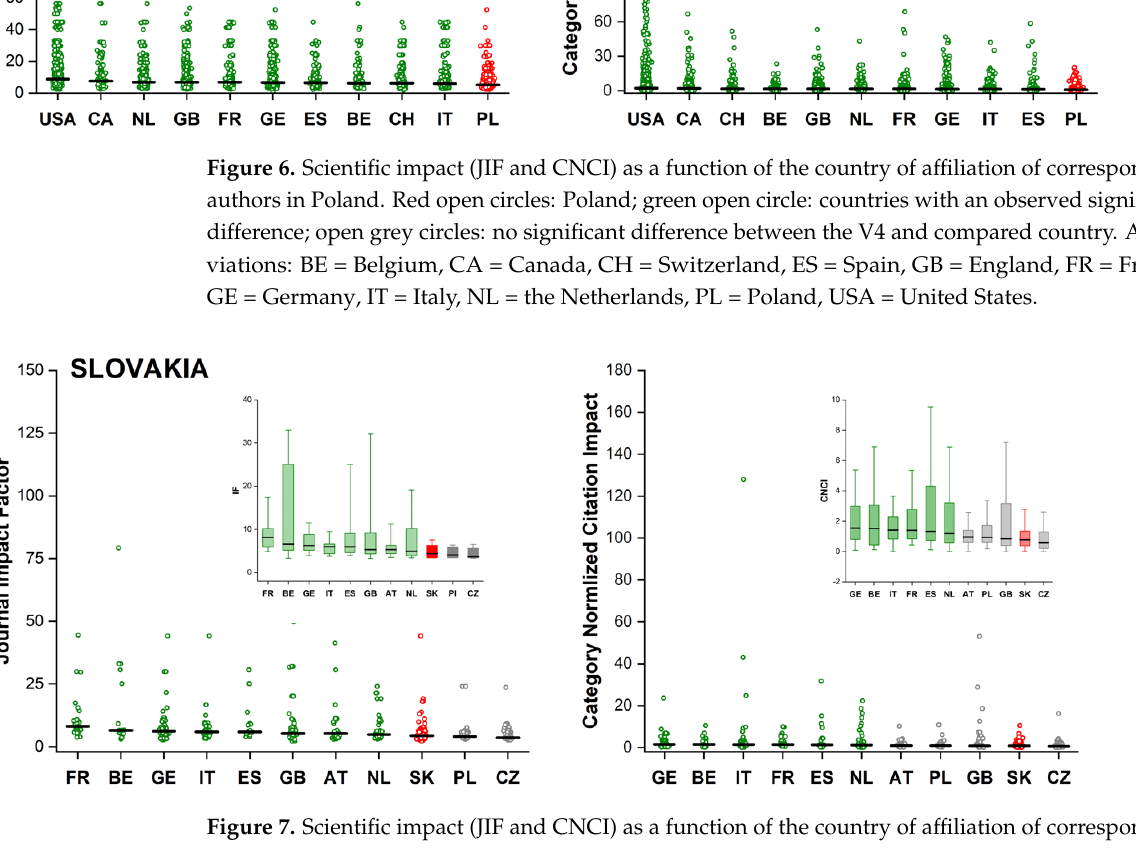
Figure 7. Scientific impact (JIF and CNCI) as a function of the country of affiliation of corresponding authors in Slovakia. Red open circles: Slovakia; green open circle: countries with an observed significant difference; open grey circles: no significant difference between the V4 and compared country. Abbreviations: AT = Austria, BE = Belgium, CZ = Czech Republic, ES = Spain, GB = England, FR = France, GE = Germany, IT = Italy, NL = the Netherlands, PL = Poland, SK = Slovakia.